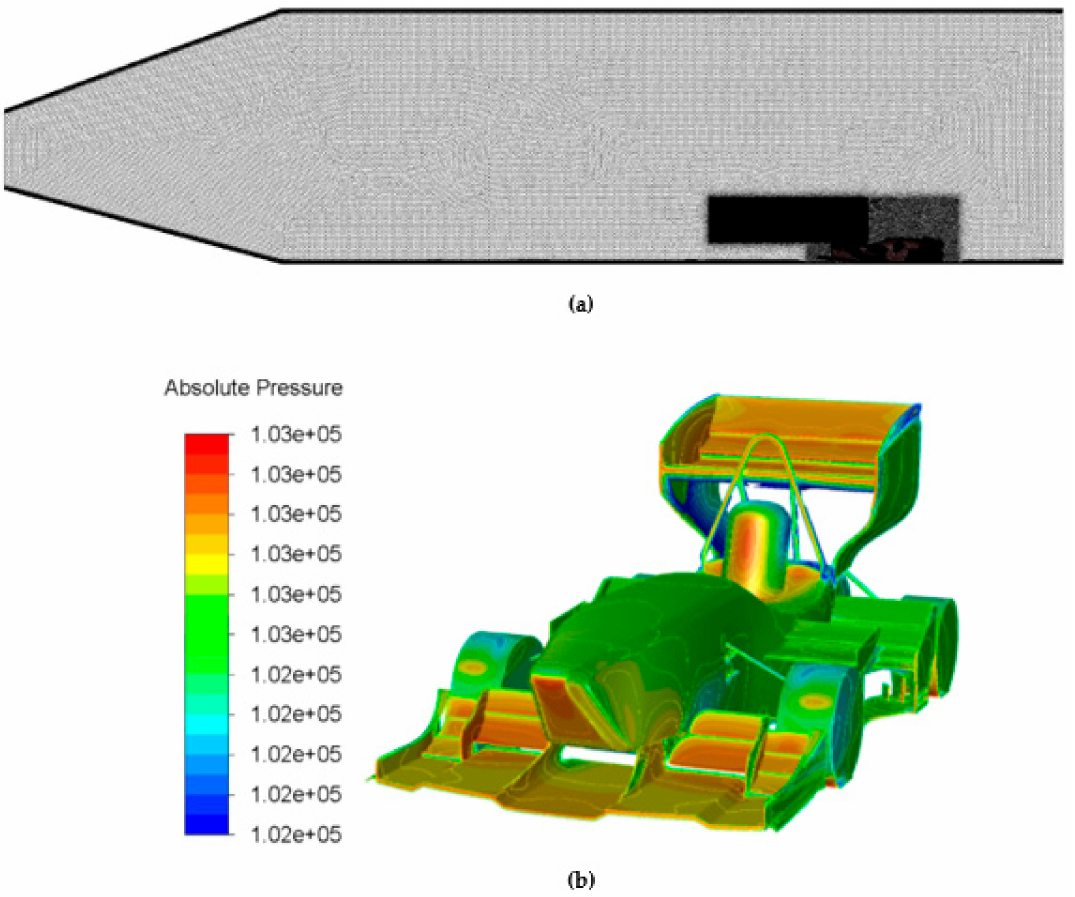
Figure 4. Excerpt from the results of the CFD workflow. ( a ) Exemplarily meshed fluid domain of the investigated case. ( b ) Pressure distribution over the structure in Pa.